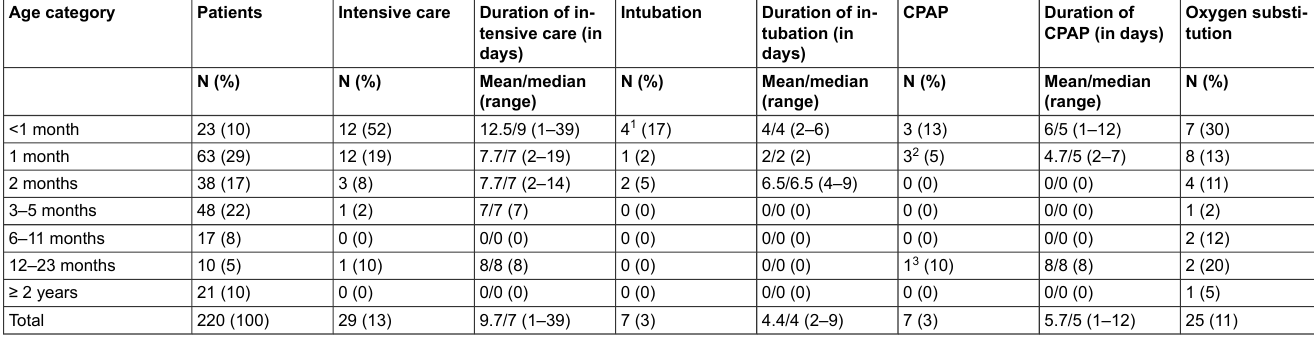
Table S6: Intensive care and respiratory